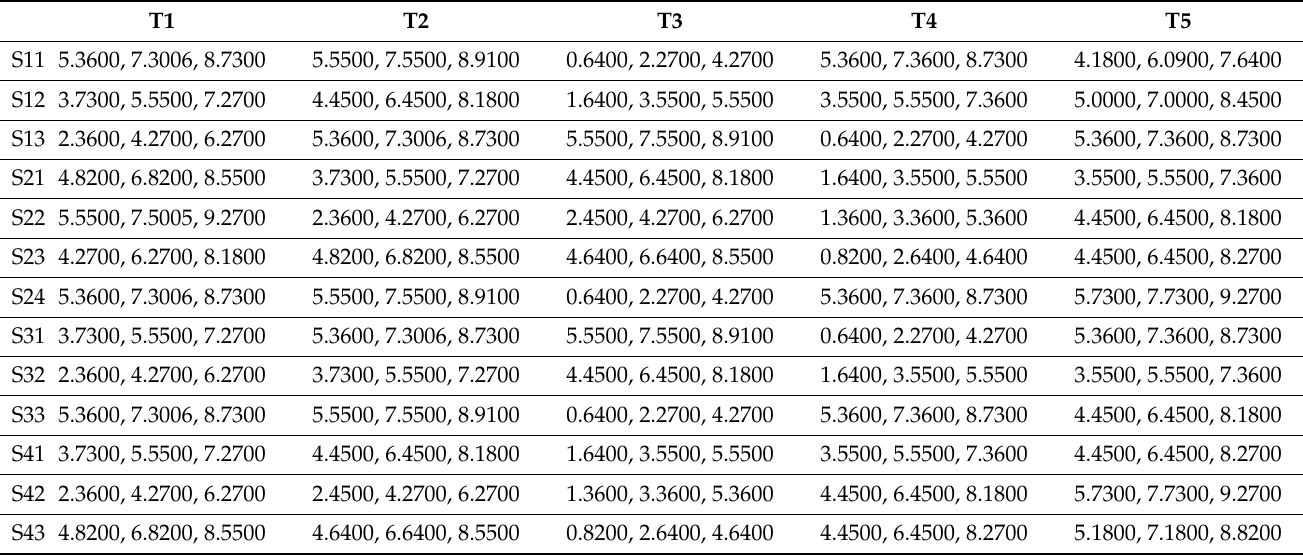
Table 12. The subjective cognition results for evaluators in linguistic